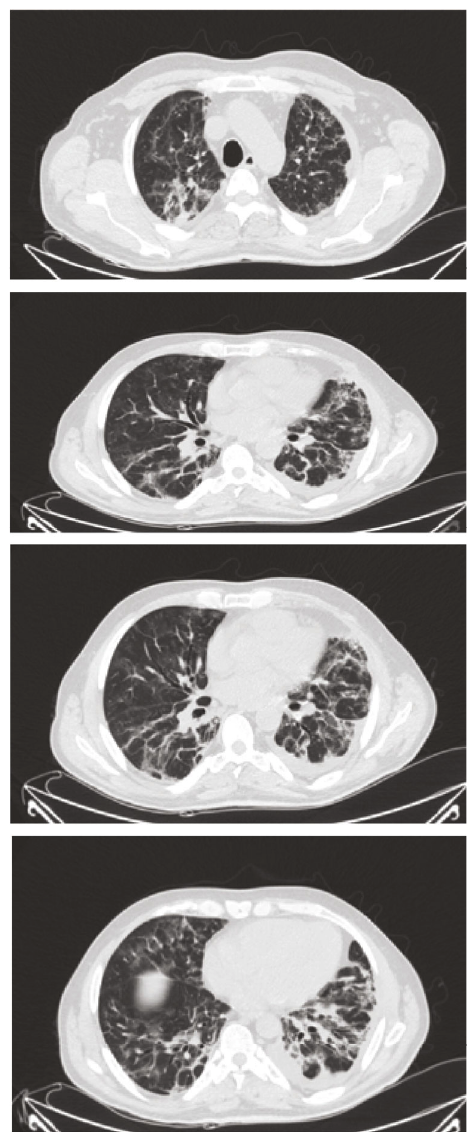
Figure 5: Chest CT showing permanent damage to the lungs by the